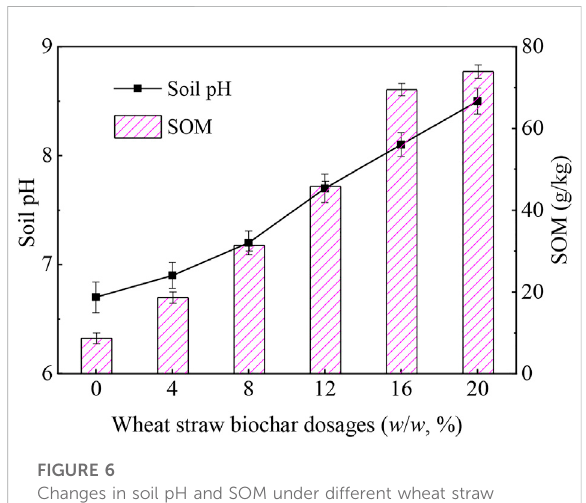
FIGURE 6 Changes in soil pH and SOM under different wheat straw biochar